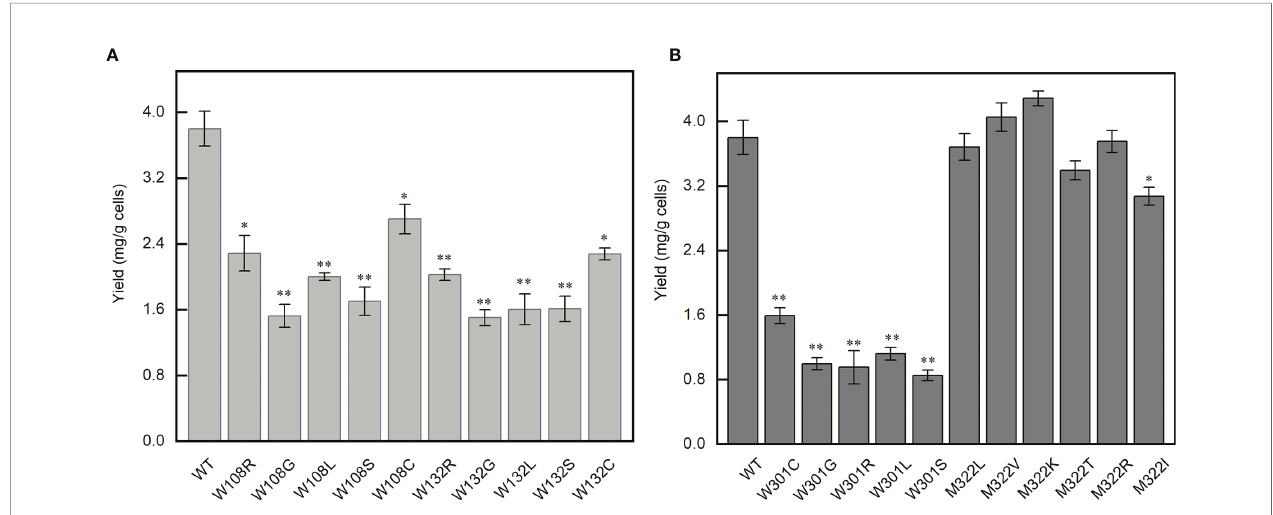
FIGURE 5 | The yield of N protein mutants expressed at 37°C. (A) The yield of the mutants at positions 108 and 132. (B) The yield of the mutants at positions 301 and 322. Statistical signi fi cance is indicated as compared with wild type using t -test. * p < 0.05; ** p < 0.01.